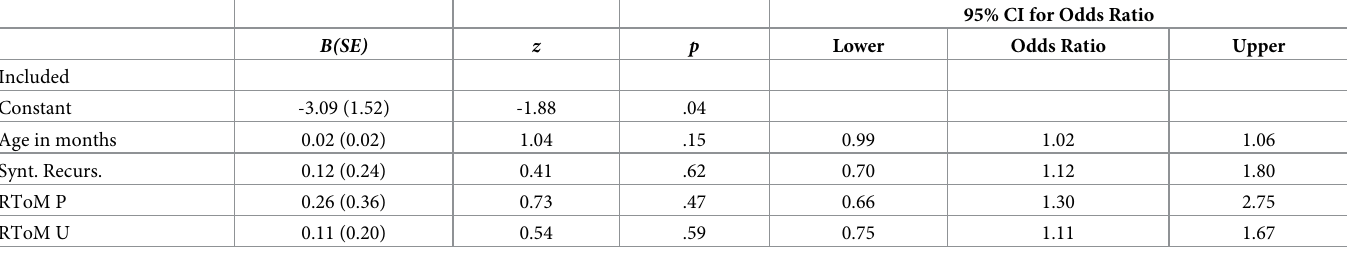
Table 6. Results of the logistic regression model predicting children’s TB performance with their age in months and their performance in tasks of syntactic recur- sion (Synt. Recurs.), Recursive ToM understanding (RToM U), and Recursive ToM Production (RToM